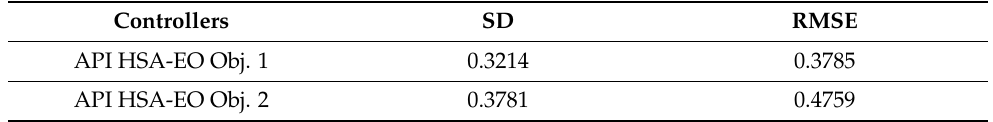
Table 14. Statistical analysis of the active power—faulty second case.